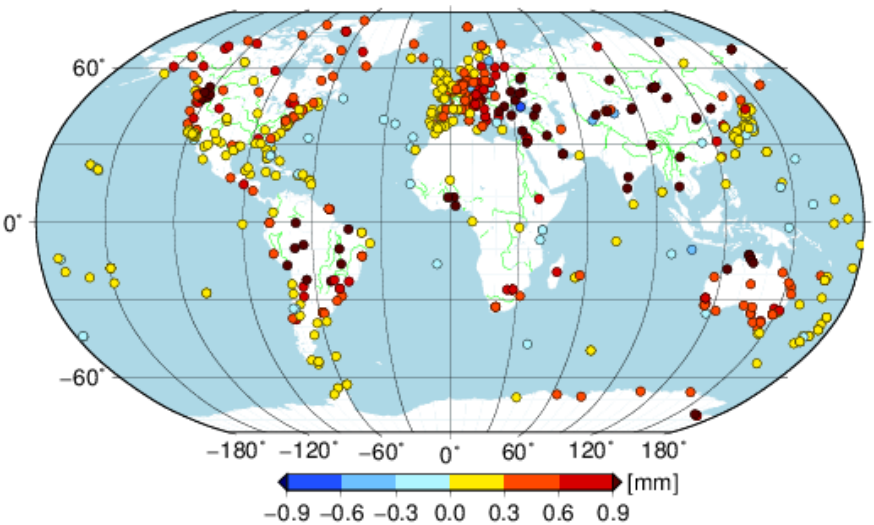
Figure 9. WRMS difference between cova_tr_s0 without and with seasonal displacement corrected by AOH model for the selected global stations for the east ( top panel ); north ( middle panel ) and vertical ( bottom panel ) component.